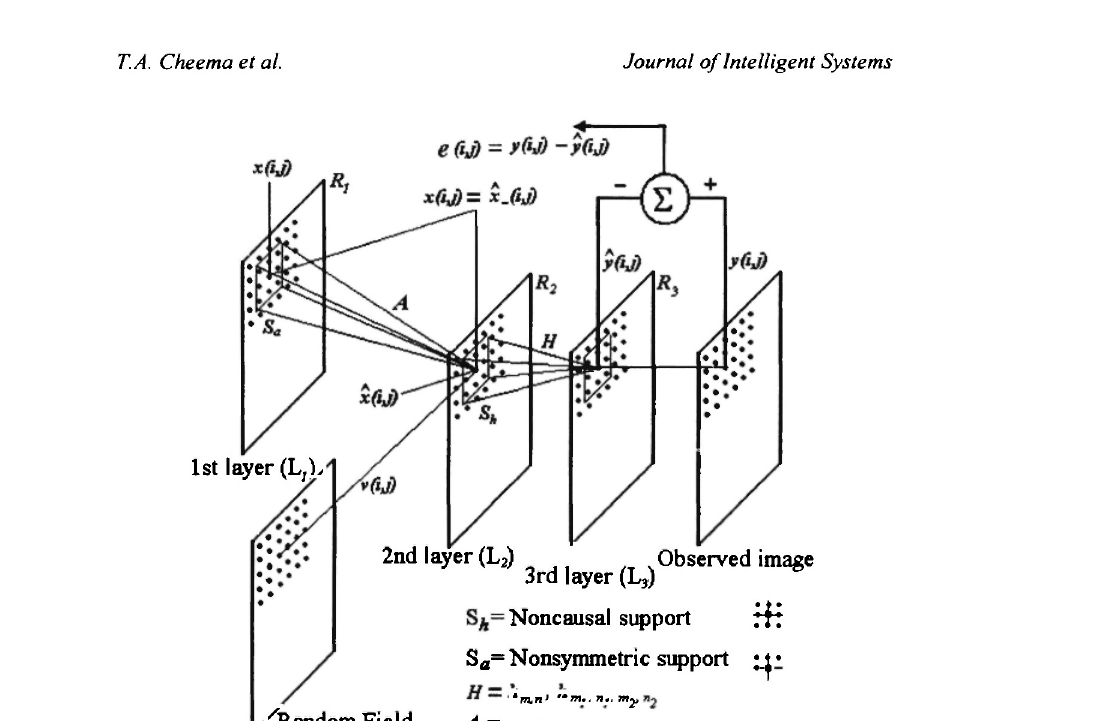
Fig. 1: The structure of the proposed artificial neural network based on ARMA model.